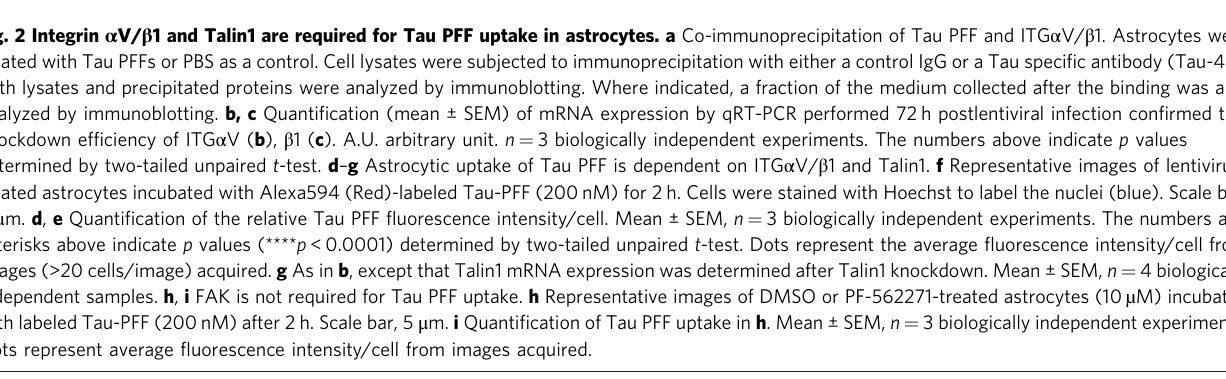
Fig. 2 Integrin α V/ β 1 and Talin1 are required for Tau PFF uptake in astrocytes. a Co-immunoprecipitation of Tau PFF and ITG α V/ β 1. Astrocytes were treated with Tau PFFs or PBS as a control. Cell lysates were subjected to immunoprecipitation with either a control IgG or a Tau speci fi c antibody (Tau-46). Both lysates and precipitated proteins were analyzed by immunoblotting. Where indicated, a fraction of the medium collected after the binding was also analyzed by immunoblotting. b, c Quanti fi cation (mean ± SEM) of mRNA expression by qRT-PCR performed 72 h postlentiviral infection con fi rmed the knockdown ef fi ciency of ITG α V ( b ), β 1 ( c ). A.U. arbitrary unit. n = 3 biologically independent experiments. The numbers above indicate p values determined by two-tailed unpaired t -test. d – g Astrocytic uptake of Tau PFF is dependent on ITG α V/ β 1 and Talin1. f Representative images of lentivirus- treated astrocytes incubated with Alexa594 (Red)-labeled Tau-PFF (200 nM) for 2 h. Cells were stained with Hoechst to label the nuclei (blue). Scale